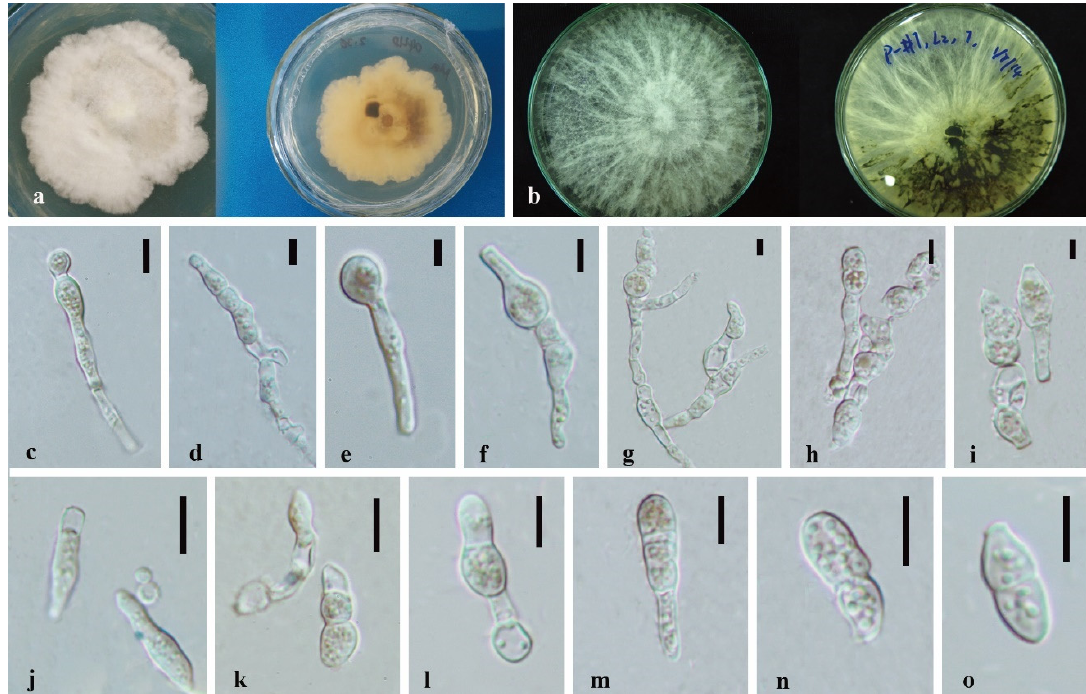
Figure 18. Xylaria grammica on PDA and WA (slide culture). ( a ) MFLUCC 14-0093 colony on PDA (left-front view, right-reverse view). ( b ) MFLUCC 14-0146 colony on PDA (left-front view, right-reverse view). ( c – i ) Conidiophores with conidia-like structures. ( j – o ) Conidia-like structures. Scale bars: ( c – i ) = 5 μ m, ( j – o ) = 10 μ m. Note: ( c – o ) on WA of slide culture.